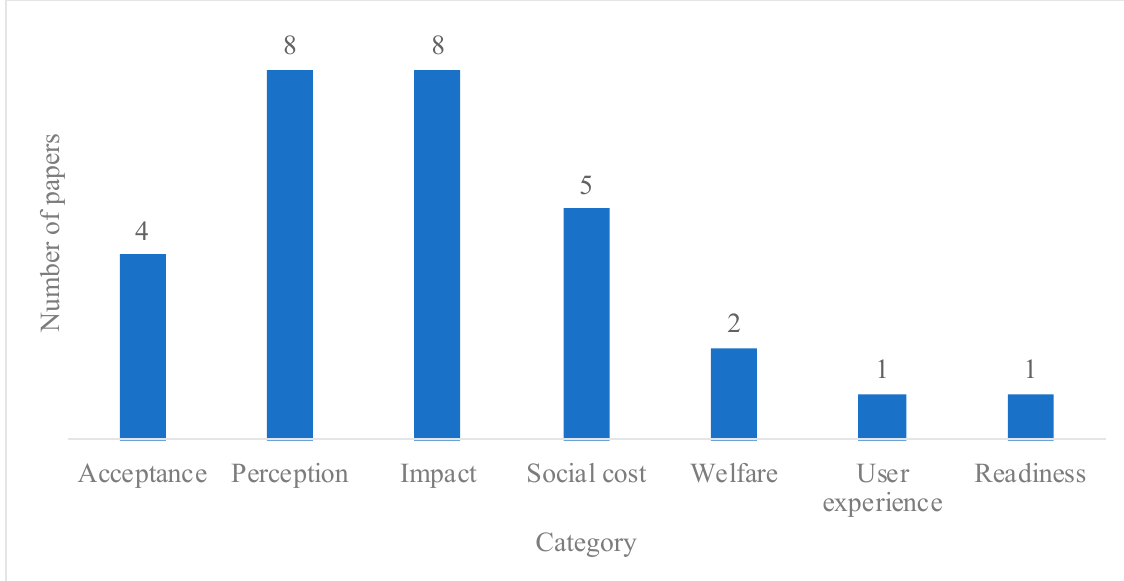
Figure 1. Published papers related to the social aspect of electric vehicles (EVs) (annual publications).